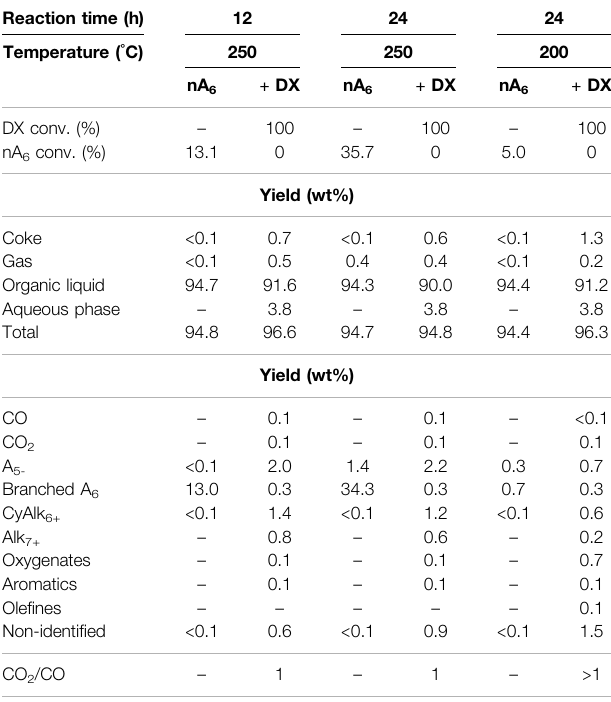
TABLE 2 | Product distribution obtained from DX HDO (10%DX (cid:1) 10 g DX in 90 g n-hexane; 5 g catalyst; 40 bar of H 2 ) carried out under different temperatures and reaction